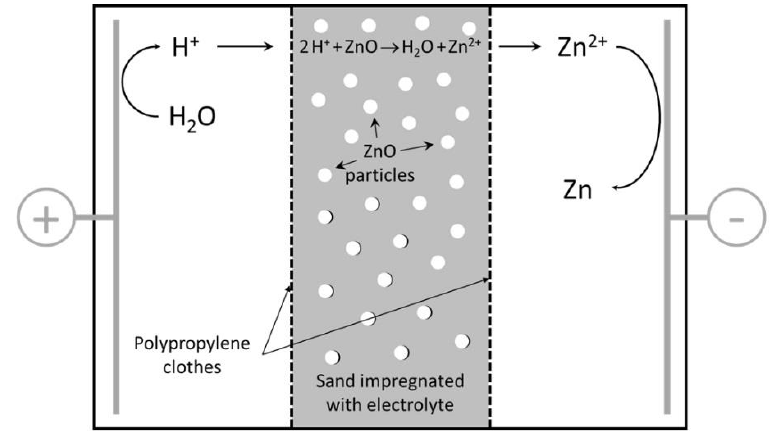
Figure 3. Cell configuration for electro-assisted leaching/electrodeposition applied to ZnO/sand mixture.